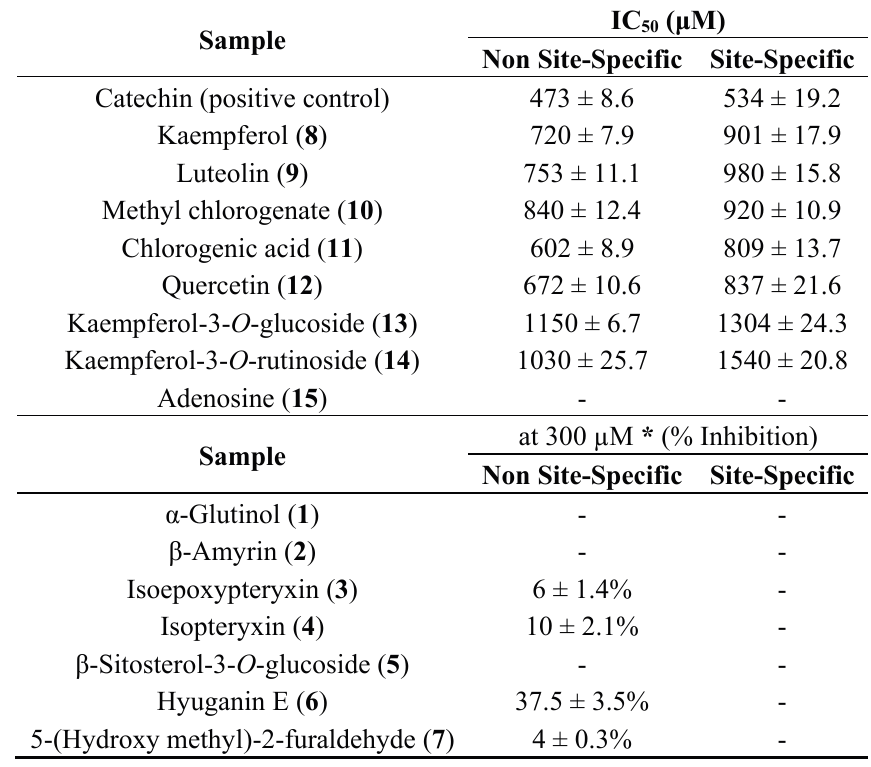
Table 3. Activity of isolated compounds for hydroxyl radical scavenging in the 2-deoxyribose degradation